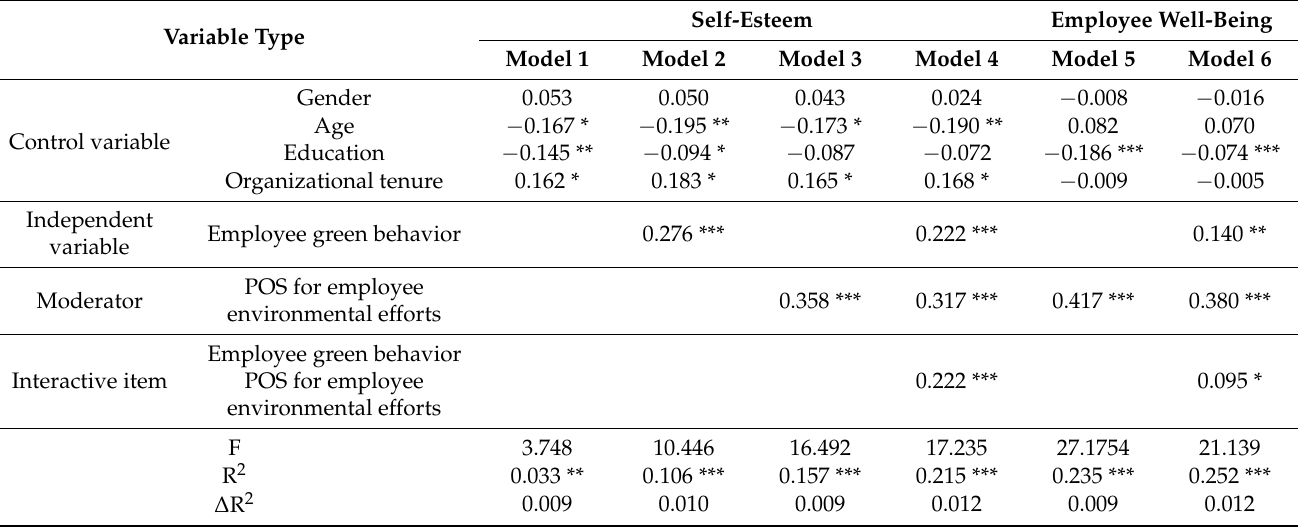
Table 5. Moderating role of perceived organizational support (POS) for employee environmental efforts. Variable